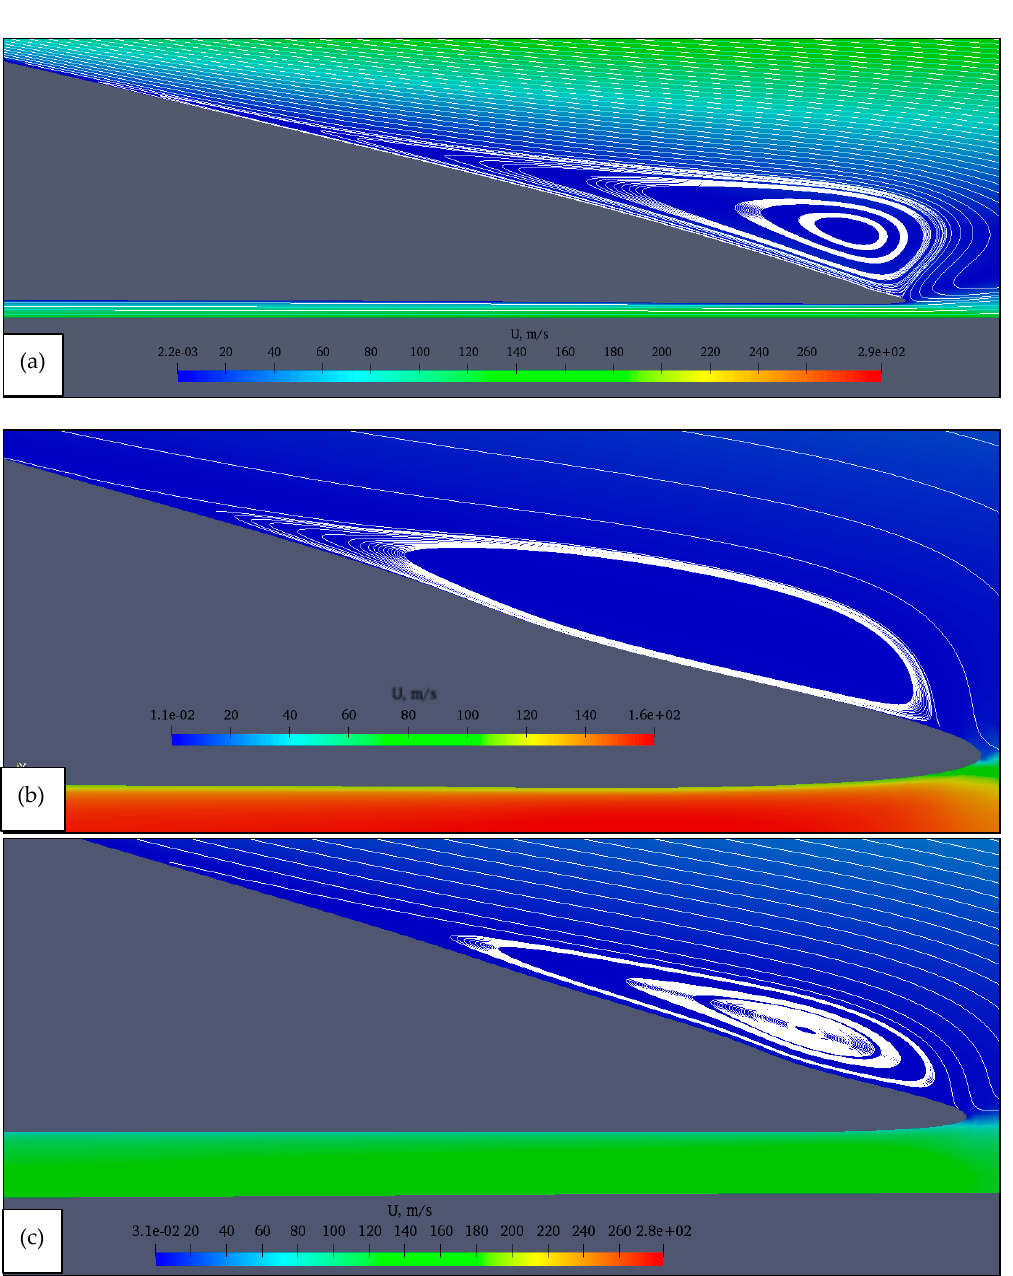
Figure 8. Recirculation zone and separation point for: ( a ) 100 Pa, ( b ) 10 kPa, ( c ) 1 bar in the tunnel.